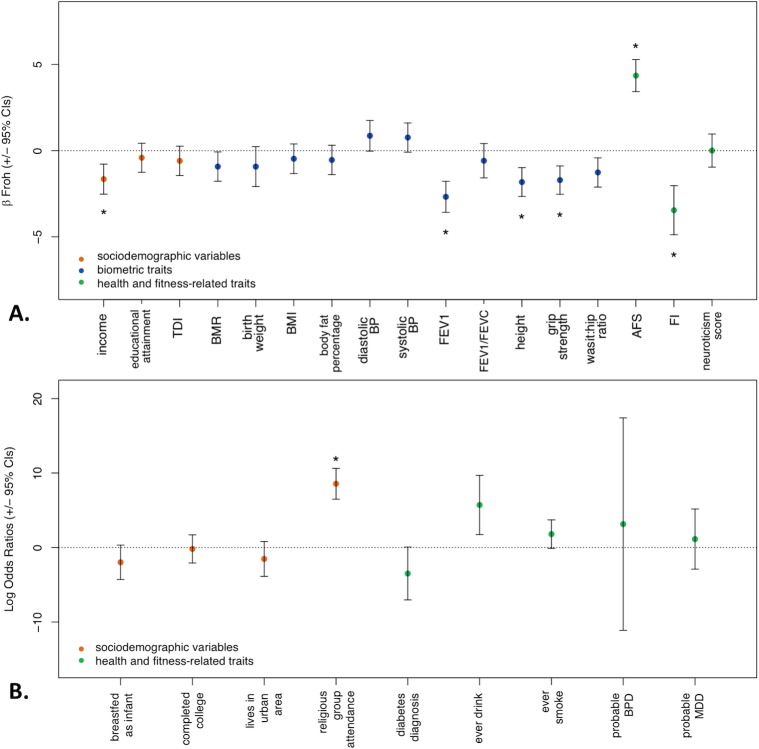
Beta FROH and 95% confidence intervals from main regression models controlling for minimal covariates (20 ancestry principal components, genotype batch, per-sample SNP missingness, age, age2, and sex).Significant estimates (at p < 0.002—corrected for multiple testing) are starred (religious group attendance as a leisure activity, income, AFS, FEV1, FI, height, and grip strength). A. All quantitative traits were analyzed in intra-sex standardized phenotypic units in linear regression models. B. Binary traits and diagnoses were analyzed using logistic regression models (the log odds ratios are reported). AFS, age at first sexual intercourse; BMI, body mass index; BMR, basal metabolic rate; BP, blood pressure; BPD, bipolar disorder; CI, confidence interval; FEV1, forced expiratory volume in 1 second; FI, fluid intelligence; FVC, forced vital capacity; MDD, major depression; TDI, Townsend Deprivation Index.